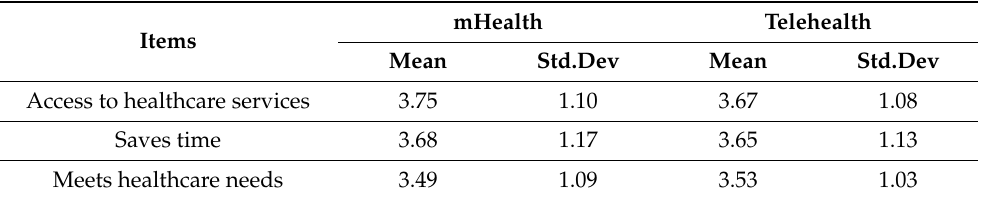
Table 2. Usefulness of mHealth and